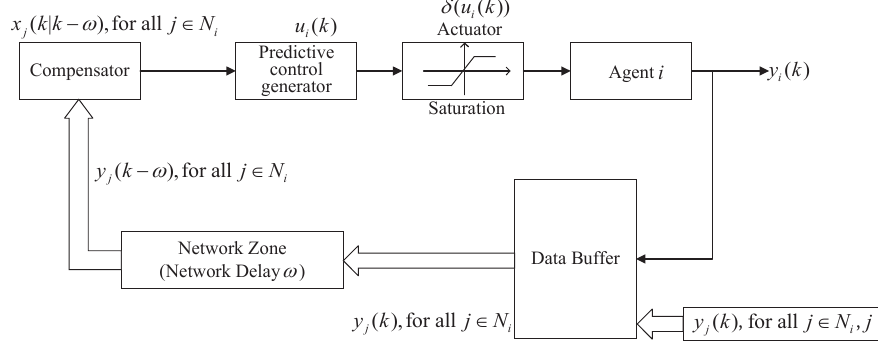
Figure 2. Structure diagram of networked predictive control at time k